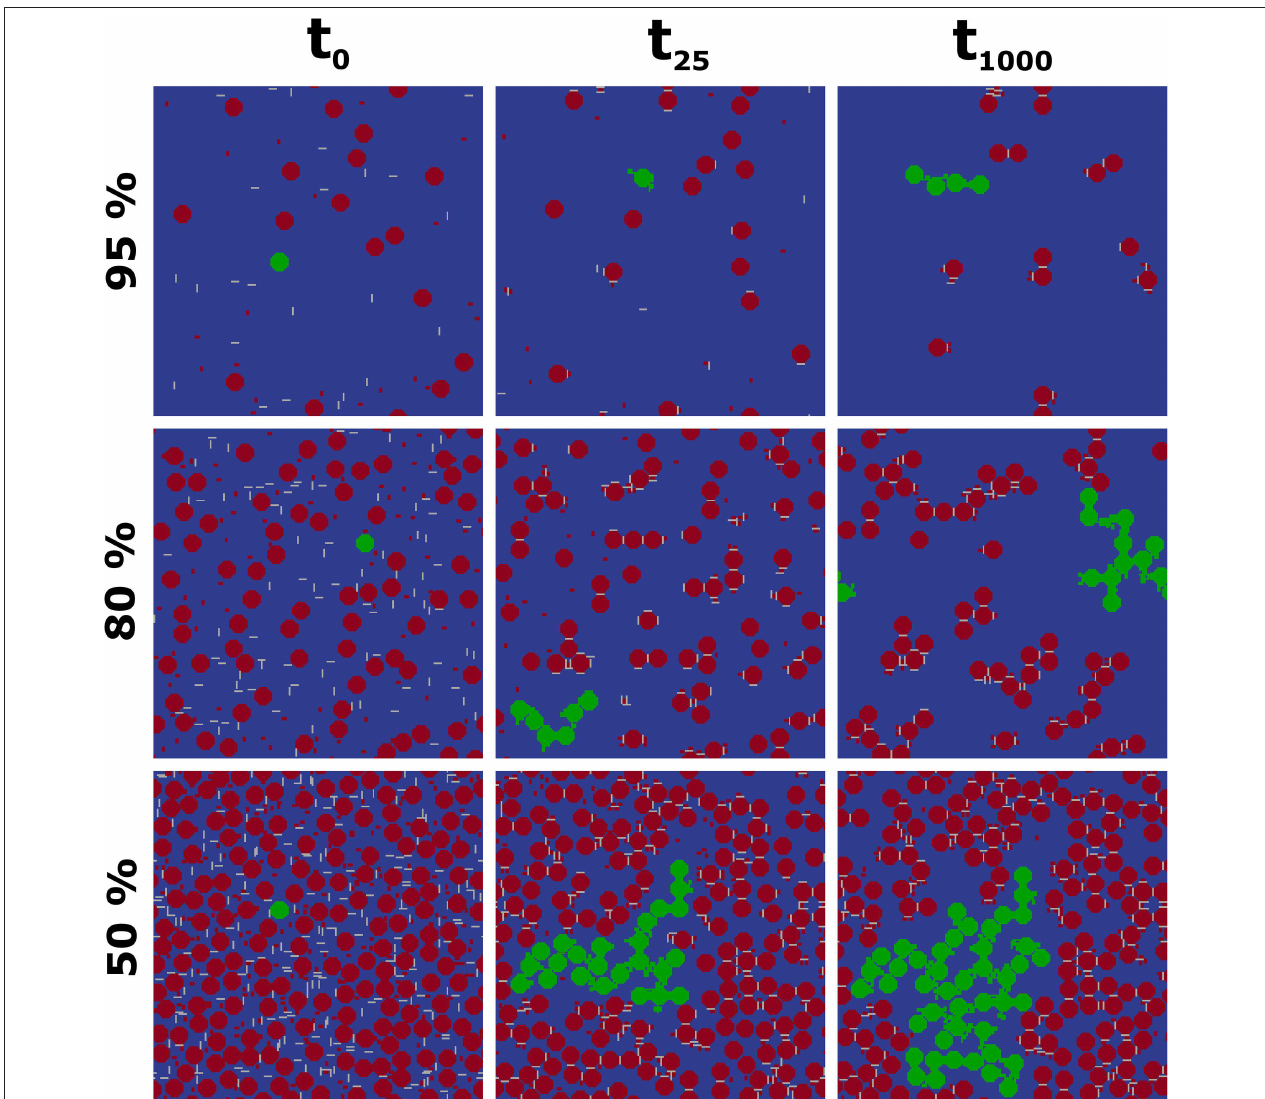
FIGURE 5 | Influence of porosity (50, 80, and 95%) on aggregate formation for a composition of 6%Gt/6%Il neg /88%Qz: Initial configuration (t 0 ), after 25 CAM steps (t 25 ), and after 1,000 CAM steps (t 1,000 ). The green color mark represents large coherent structures in the given images (t o : single Qz, no aggregation occurs; t 25 and t 1,000 : in size increasing aggregates over time including Il, Gt, and